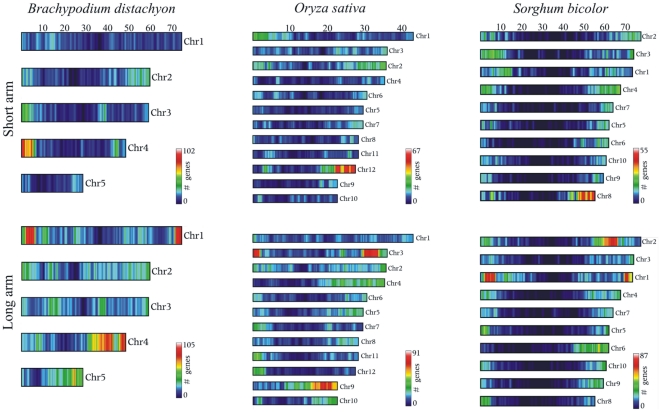
Wheat 5A sequence reads mapped on the genome of Brachypodium, rice and sorghum.The genes of Brachypodium, rice and sorghum with a significant similarity at the amino acid level with the wheat 5A reads obtained in this work were plotted along their position on the chromosomes of their respective organism. To highlight regions containing a high proportion of putative homologous genes, the average syntenic content was calculated as the number of wheat matching proteins in a window of 1Mb with shift of 20Kb. Note that color scale is specific for each arm and genome, therefore a direct comparison of the gene density between the different genomes is not possible.